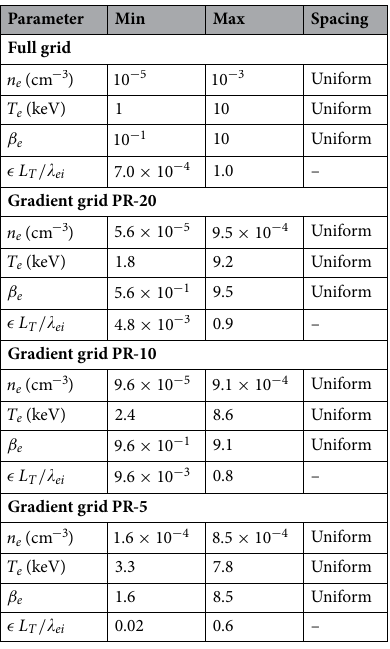
Table 1. Grid of parameter space: range and spacing for the grids of plasma parameter values at which the heat flux function (top) and its gradient (bottom three panels) are evaluated at different sampling density ( N ppd ). For each Table section, the last line shows the range of values of the heat-flux suppression factor. The 3 10 22 temperature gradient length is fixed at L T = ×